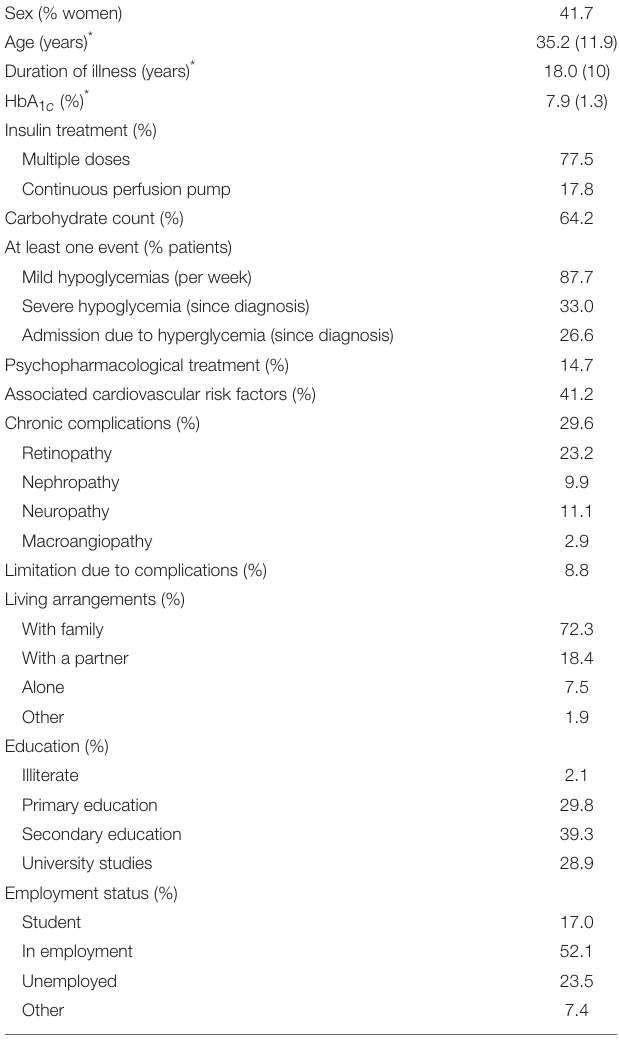
TABLE 2 | Participants’ characteristics. ( N =